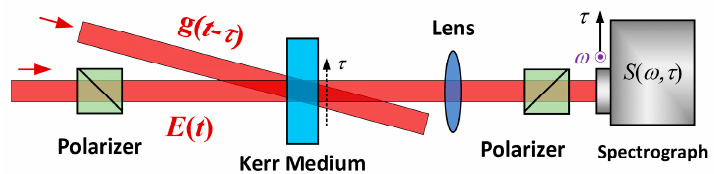
Figure 2. Schematic of PG-FROG. Time-to-space encoded scanning is caused by cross